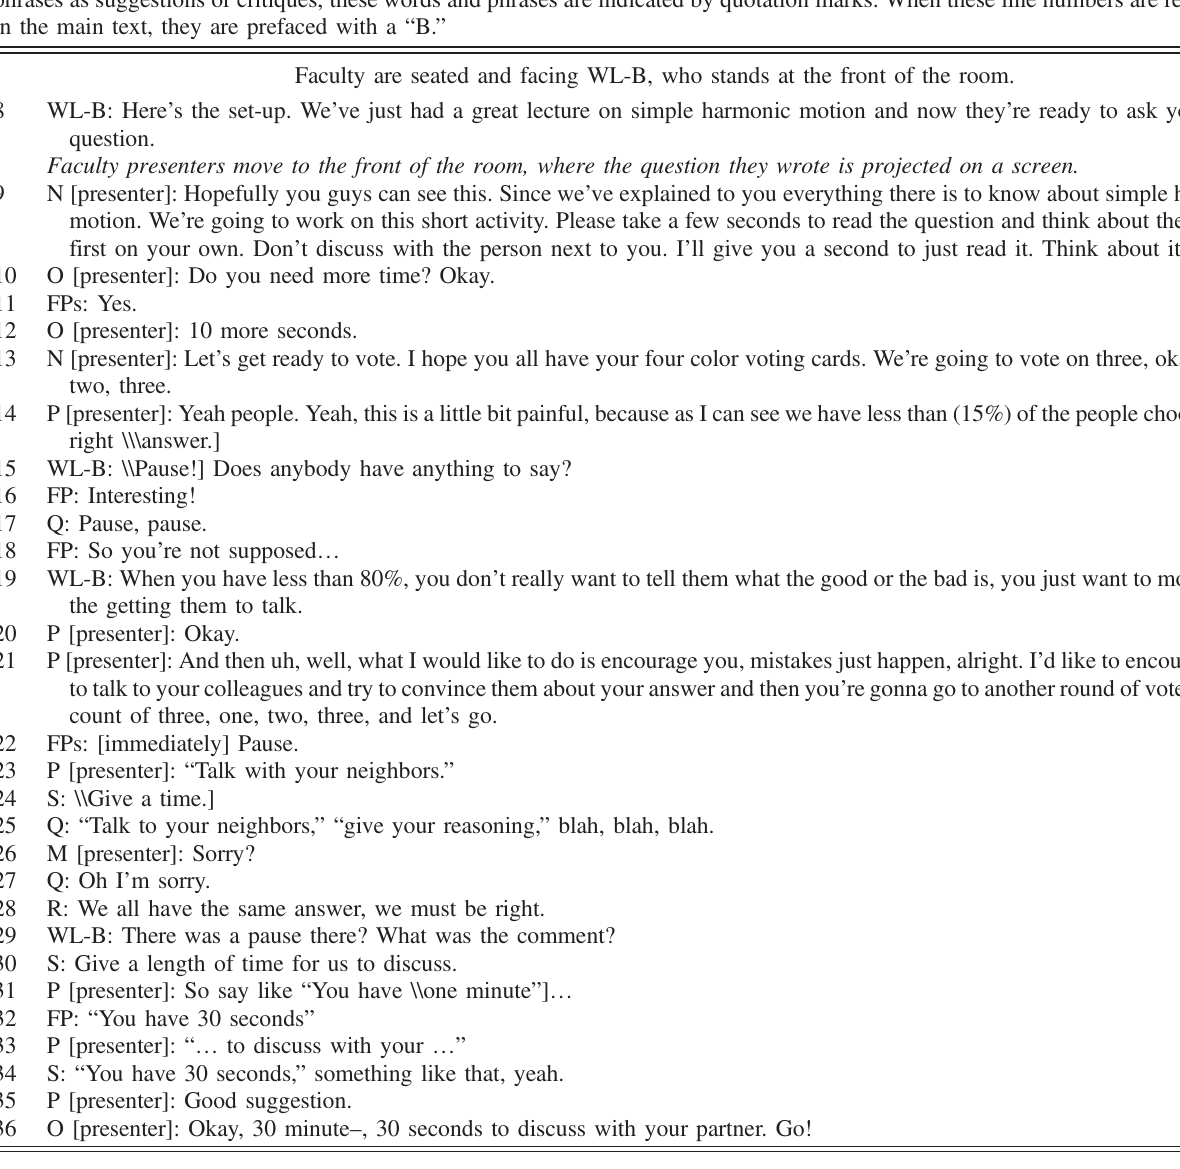
TABLE IV. Transcript of the first group of presenters being paused and critiqued in Session B. When faculty offer scripted words and phrases as suggestions or critiques, these words and phrases are indicated by quotation marks. When these line numbers are referenced in the main text, they are prefaced with a “ B.